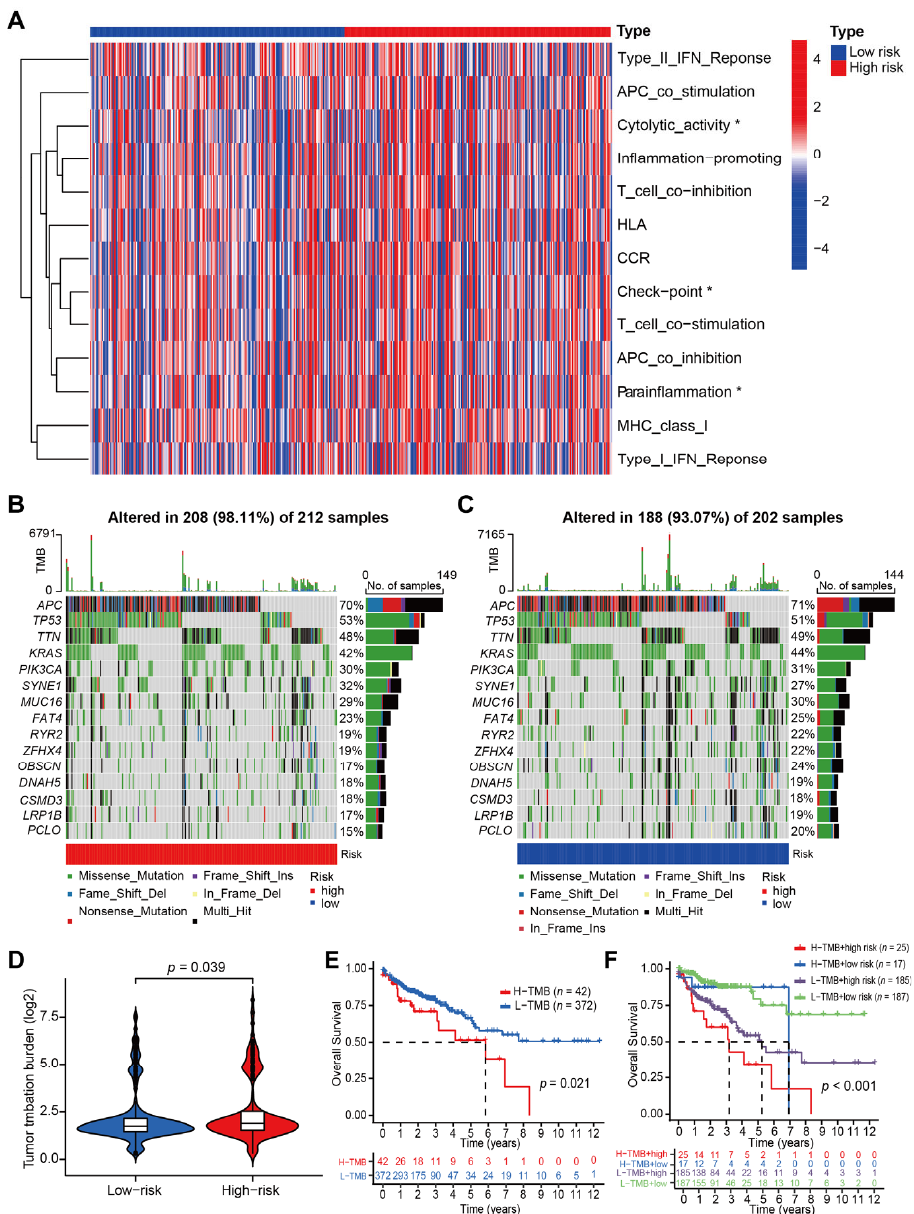
Figure 6. GVSA analysis of prognostic characteristics and TMB analysis. ( A ) Immune pathway enrichment heatmap for prognostic characteristics in CC patients with high and low CRLs-risk score (* p < 0.05). ( B , C ) Oncoplot demonstrating tumor mutational burden in CC patients with high ( B ) and low ( C ) CRLs-risk score. ( D ) Violin plot for statistical analysis of TMB in high CRLs-risk and low CRLs-risk CC patients ( p = 0.039). ( E ) Kaplan–Meier survival curve of OS in high TMB and low TMB CC patients ( p = 0.021). ( F ) Kaplan–Meier survival curve of OS in CC patients with different TMB status and risk score ( p < 0.001).